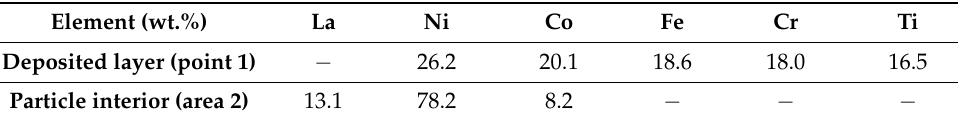
Figure 2. ( a ) Polished cross-section of isolated LaNi 4.5 Co 0.5 powder particle coated with the magnetron sputtered TiCrFeCoNi layer. The numbers denote EDS analysis areas: 1-HEA layer and 2-particle interior; ( b , c )-the EDS spectra from the particle surface layer (point 1 in ( a )) and particle interior (area 2 in ( a )). Table 1. The average chemical composition (at.%) of the sputtered layer and particle interior determined by the EDS analysis (points 1 and area 2 in Figure 2a).